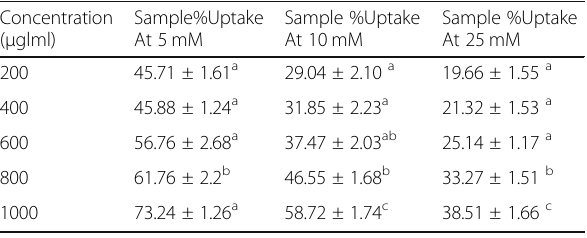
Table 1 Alpha Amylase Inhibitory Activity of Methanol Extract of Chromolaena odorata Whole Root